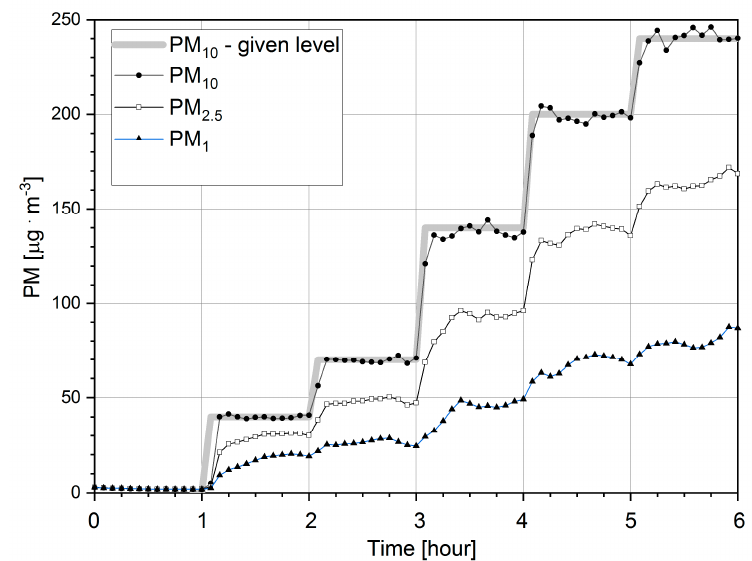
Figure 5. The concentrations of particulate matter PM 1 , PM 2.5 and PM 10 recorded as a function of time by reference station EDM 107 during the background level measurement (the first hour) and the programed five levels at 40, 70, 140, 200 and 240 µ g · m − 3 . The data presented in this figure are the mean values of 5 min long measurements.